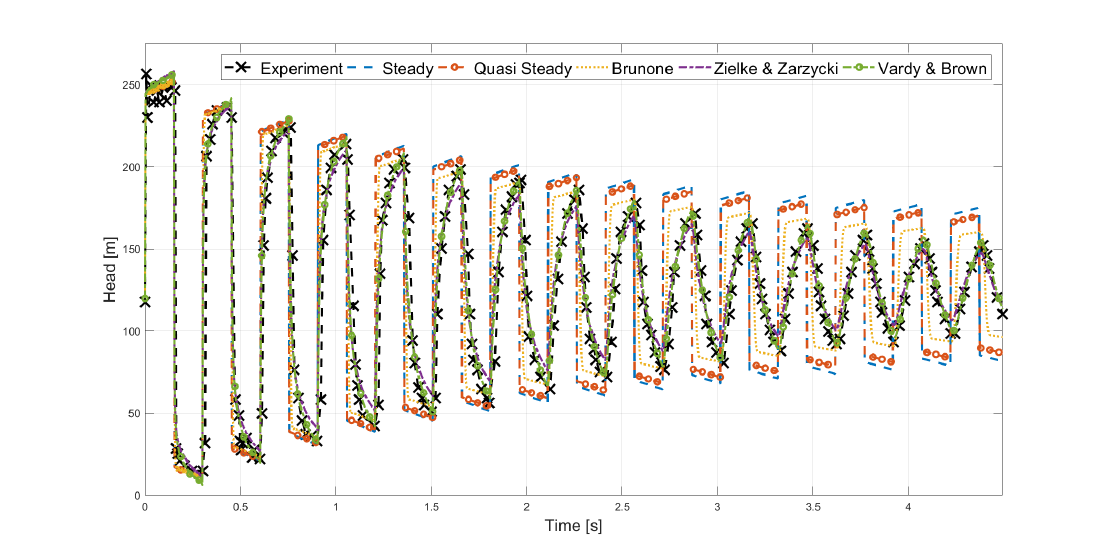
Figure 6. Comparison of the experimental data (experiment 2 [40])with the simulated results for each friction model. Note that Zielke and Zarzycki friction models gave similar results.